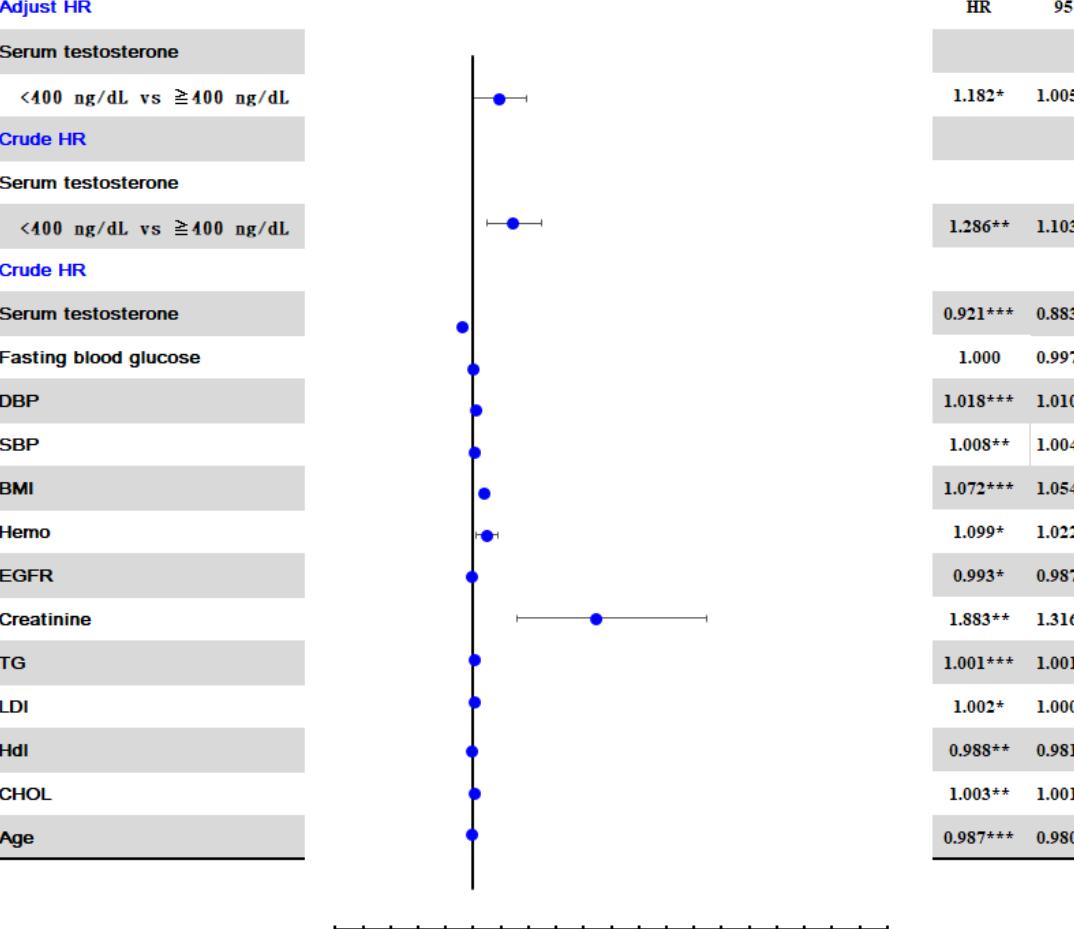
Figure 2. Risk factors for developing hyperuricemia (SU ≥ 7 mg/dL). Abbreviations: HR, hazard ratio; SU, serum urate. * p < 0.05; ** p < 0.01; *** p < 0.001.